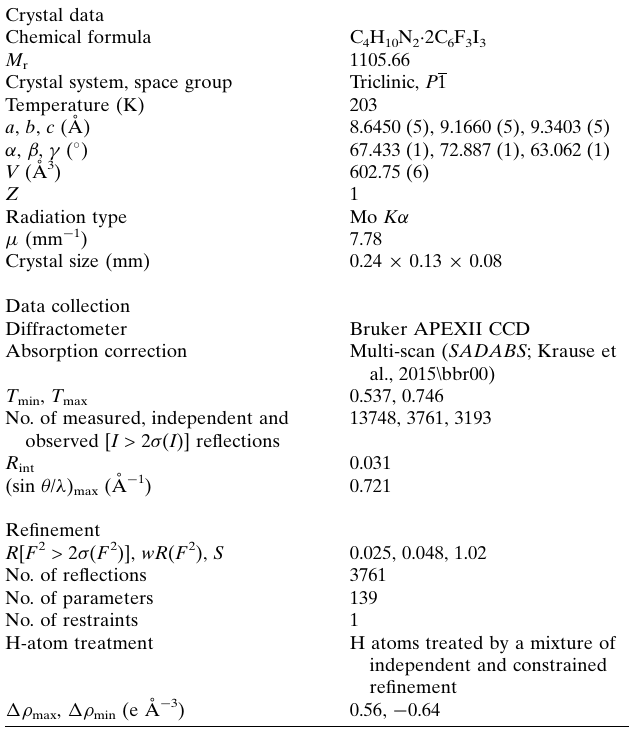
Table 2 Experimental details. Crystal data Chemical